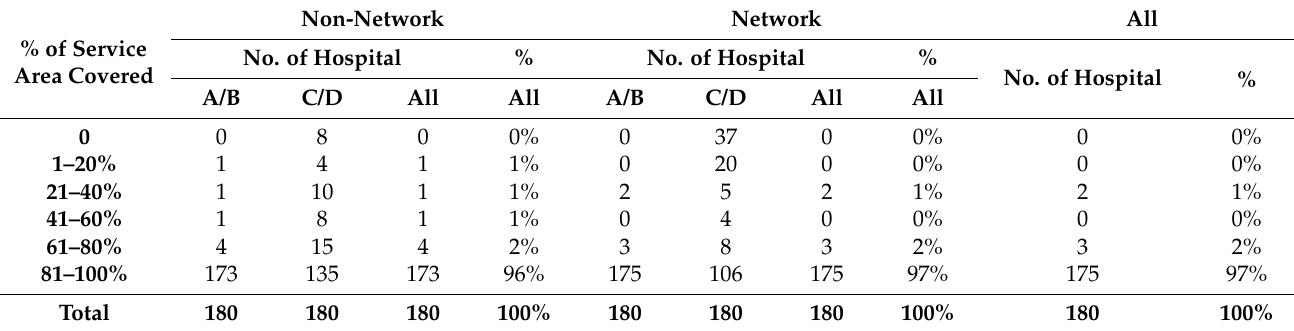
Table 4. Number of sub-districts in range of service areas